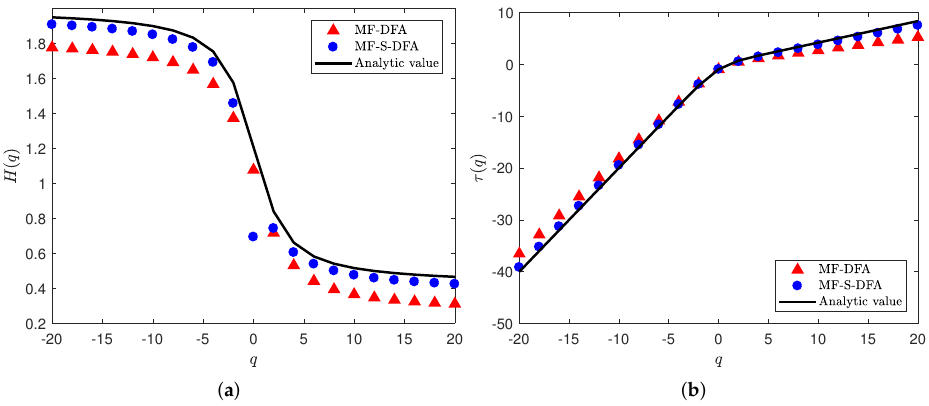
Figure 3. Multifractal analysis of the constructed multiplicative cascade time series of ( a ) generalized Hurst exponent H ( q ) calculated by MF-DFA and MF-S-DFA and analytical value and ( b ) mass exponent spectrum τ ( q ) calculated by MF-DFA and MF-S-DFA and analytical value. A color version of the figure is available in the web version of the